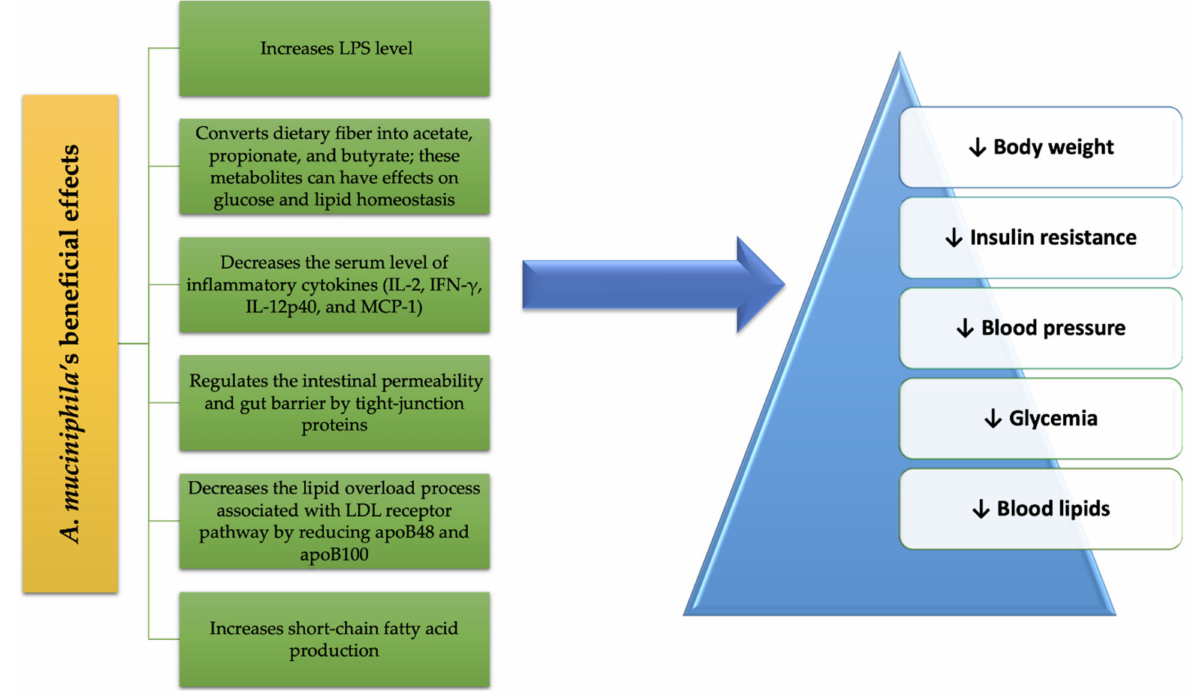
Figure 2. A. muciniphila ’s benefits in